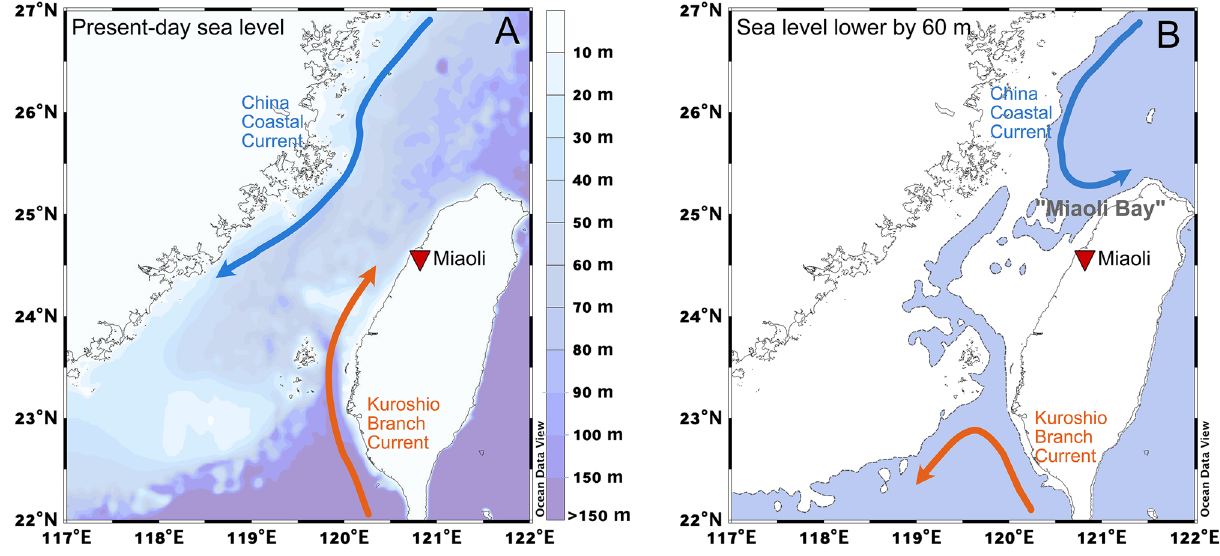
Figure 5. Surface ocean circulation in the Taiwan Strait at different sea levels. ( A ) Present-day sea level and ( B ) when the sea level was lower by ~ 60 m during MIS 3 (30–50 ka) (Ref. 16 ). Color bar in panel A represents ocean bathymetry. In panel B, the area covered by ocean is shaded blue, while land is shaded white. Maps were generated using Ocean Data View (https:// odv. awi. de/, version